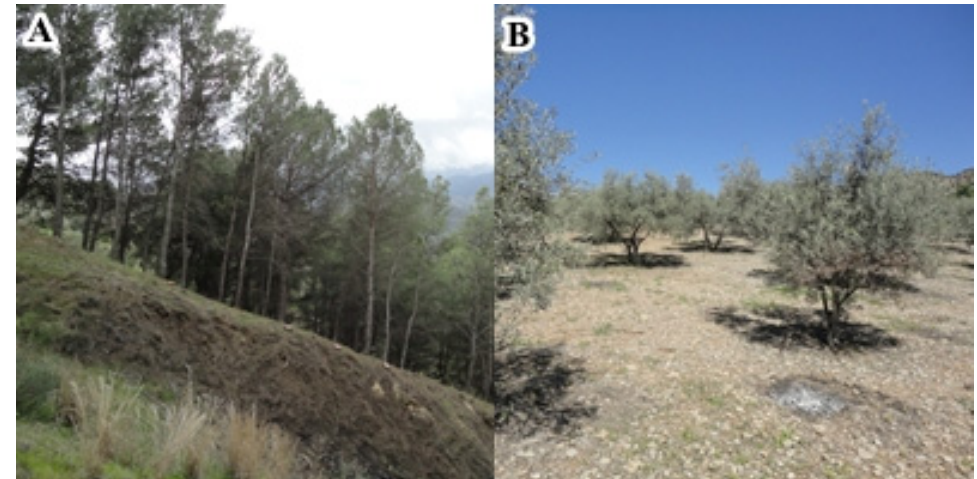
Figure 6. Examples of evidence collected in the field work. ( A ) Very high quality in GR. ( B ) Very low quality in BE.